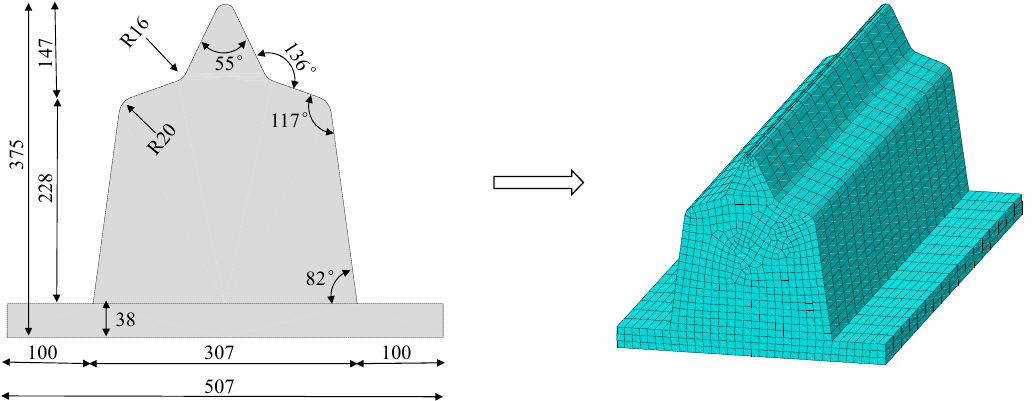
Figure 17. Geometry and finite element mesh of GINA gasket.